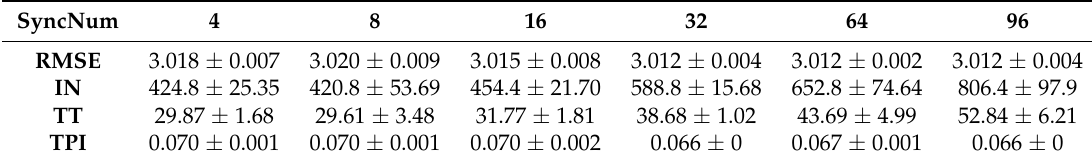
Table 14. Comparison of different SyncNum in MG-ACOEE on the parallel performance for Cuprite data.